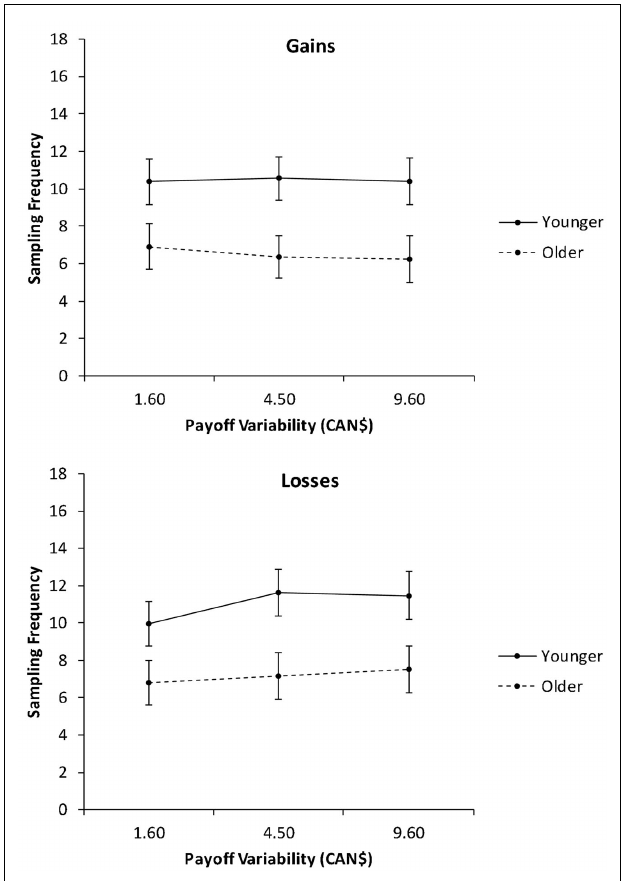
FIGURE 4 |The proportion of risky choices as a function of valence and the probability of the desirable outcome ( p desirable ), for younger and older adults. Adjusted means for the average level of the covariate (years of education) are shown. Error bars show the